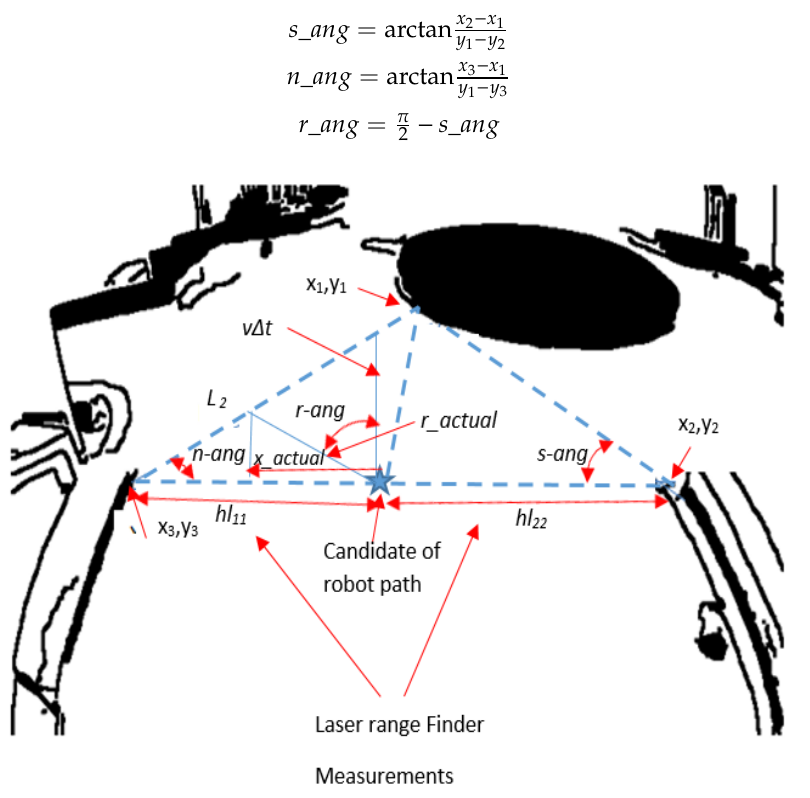
Figure 13. Entrance parameters and path determination of roundabout.